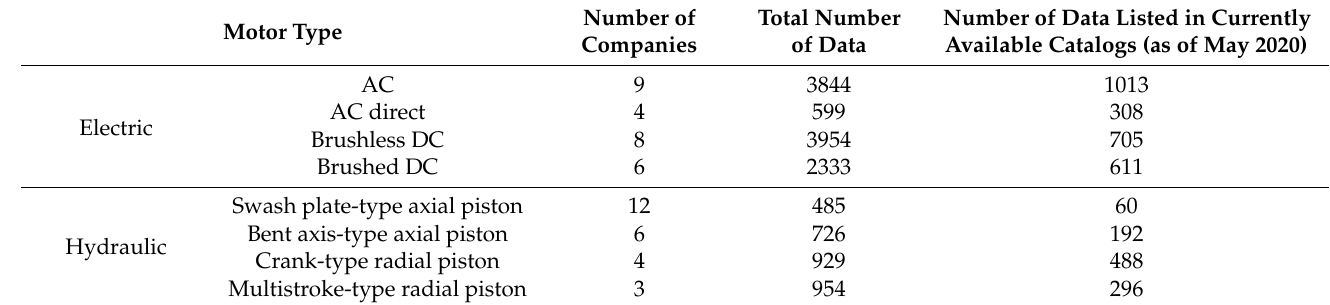
Table 1. Survey targets for the comparison of servo motor